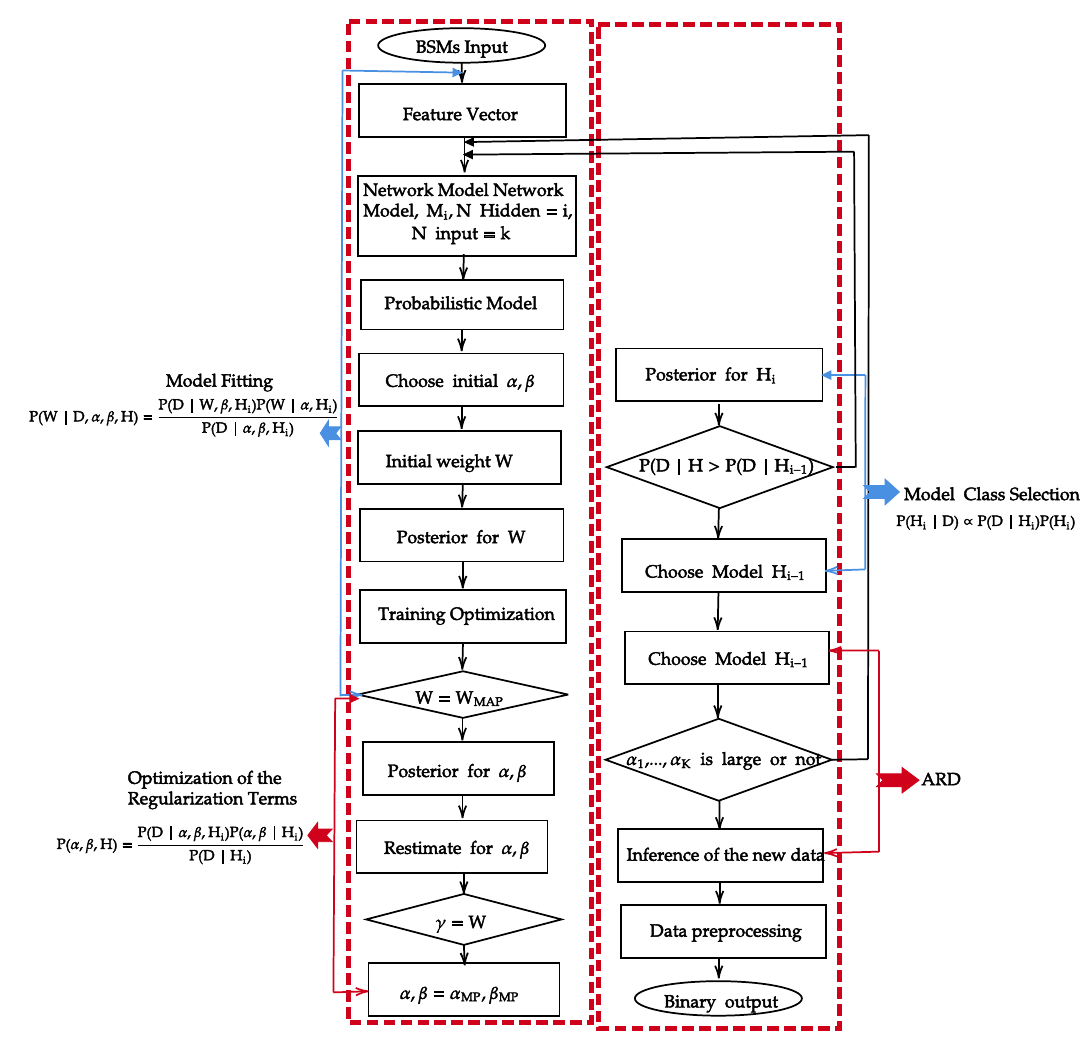
Figure 7. Bayesian Hierarchical Framework for Neural